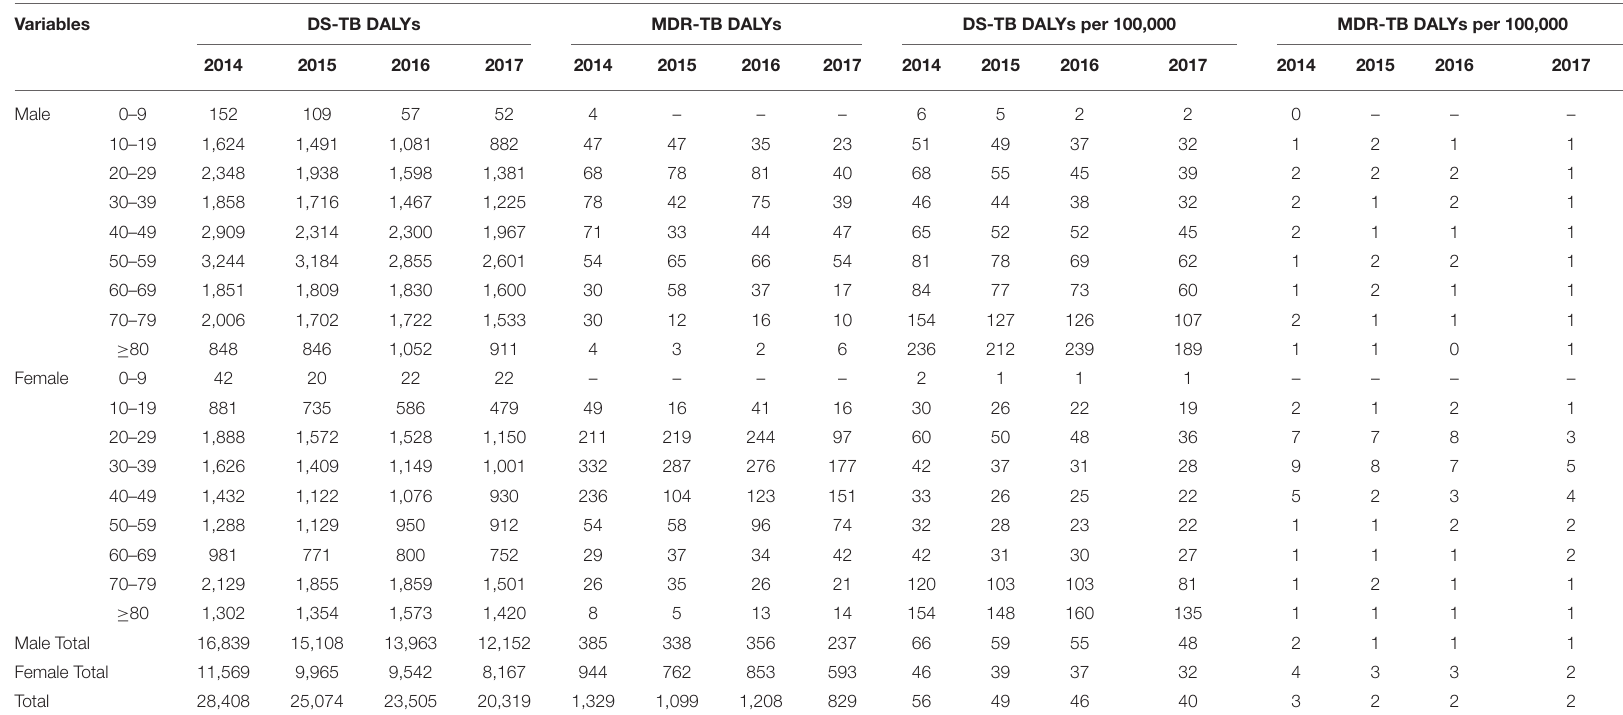
TABLE 3 | Disability-adjusted life years (DALYs) due to drug-susceptible tuberculosis (DS-TB) and multidrug-resistant tuberculosis (MDR-TB) by gender and age, DALYs per 100,000 people, 2014–2017.